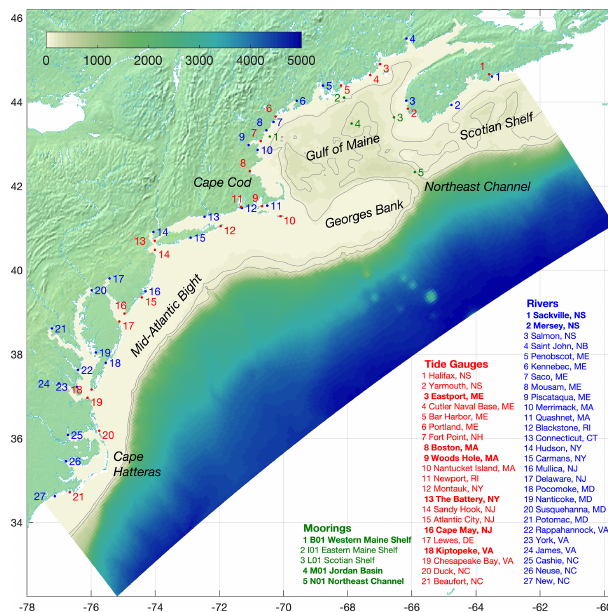
Figure 1. Doppio bathymetry with markers for all rivers used to force the model and tide gauges and moorings used for statistical comparisons. Those in bold are referenced in Figs. 4, 5, 8, 9, and